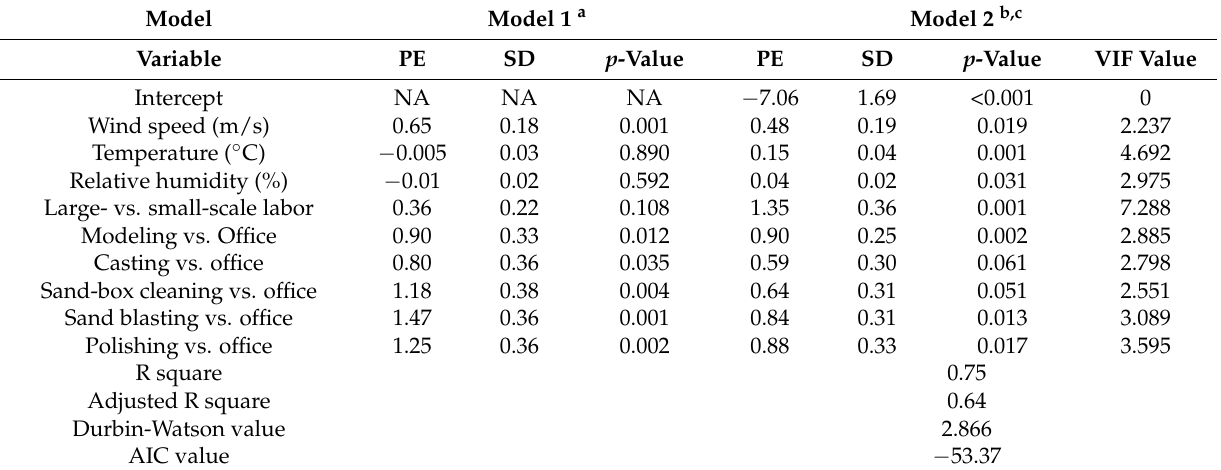
Table 3. Associations between climatic factors, labor scales, production areas, and levels of respirable dust ( n = 30).